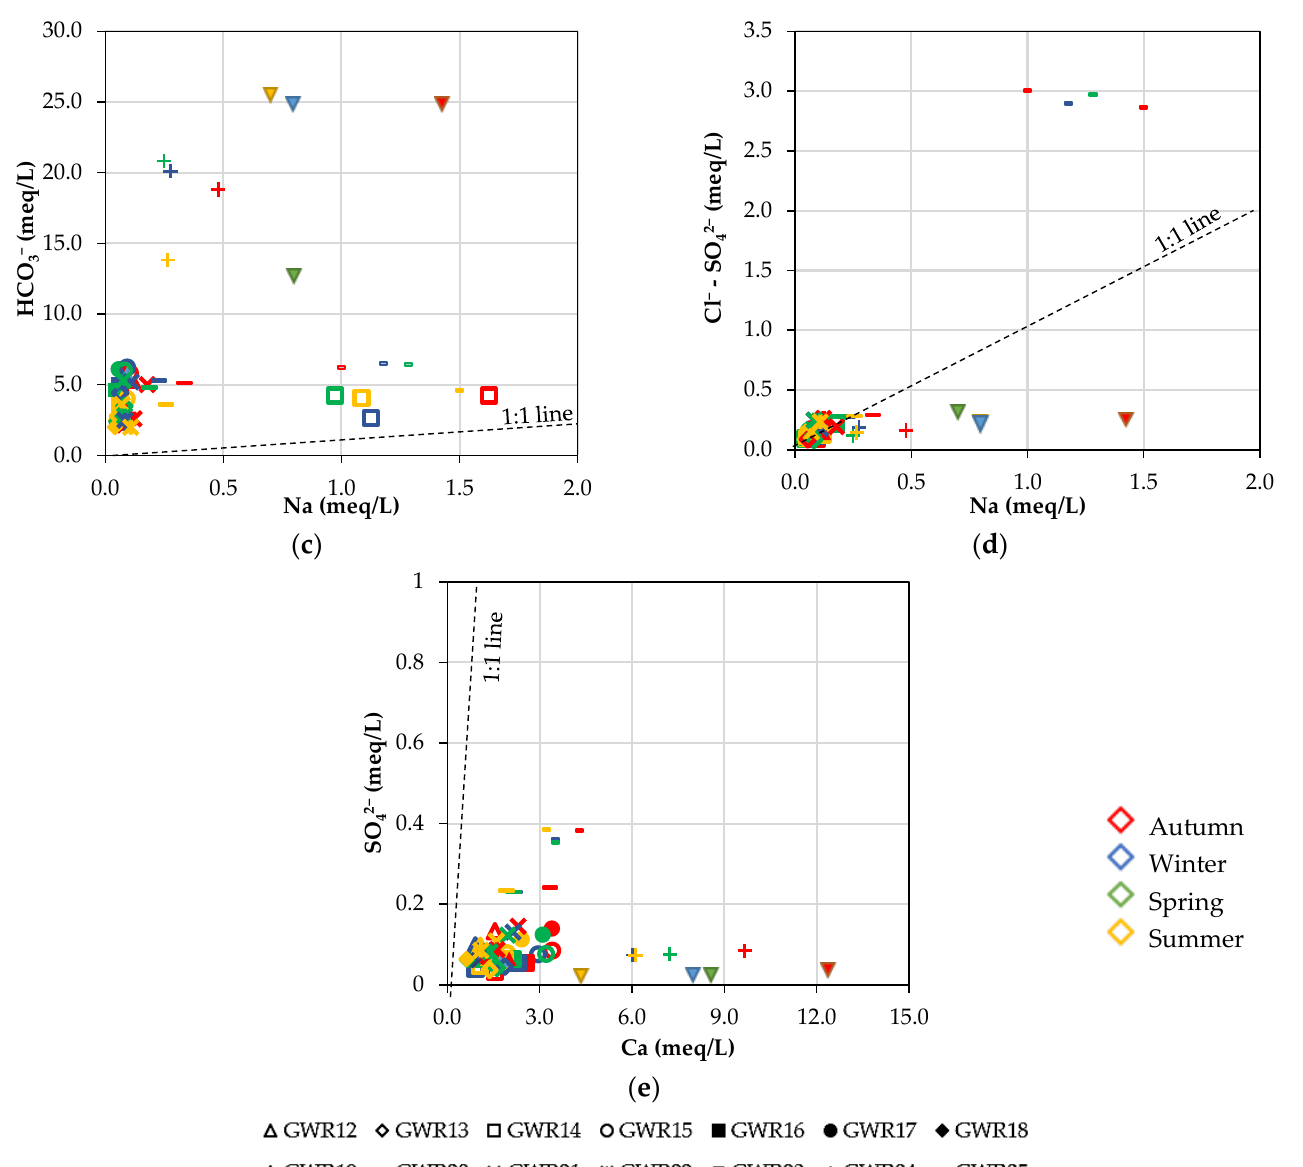
Figure 3. Scatterplots showing the correlation between major cations/anions to discriminate the geochemical processes in the four seasons: ( a ) Na vs. Cl − , ( b ) (SO 4 2 − + HCO 3 − ) vs. (Ca + Mg), ( c ) Na vs. HCO 3 − , ( d ) Na vs. Cl − − SO 42 − , ( e ) Ca vs. SO 4 2− .